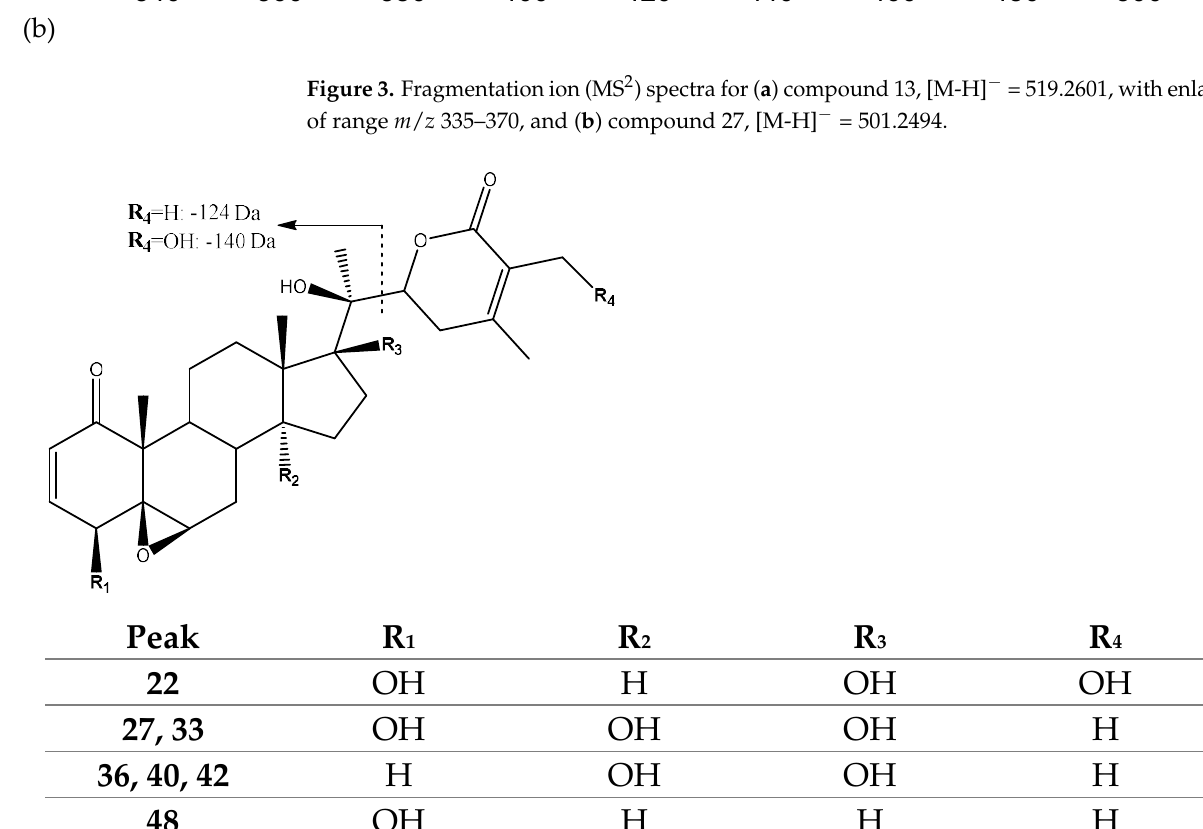
Figure 3. Fragmentation ion (MS 2 ) spectra for ( a ) compound 13, [M-H] − = 519.2601, with enlarge- ment of range m/z 335–370, and ( b ) compound 27, [M-H] − = 501.2494.